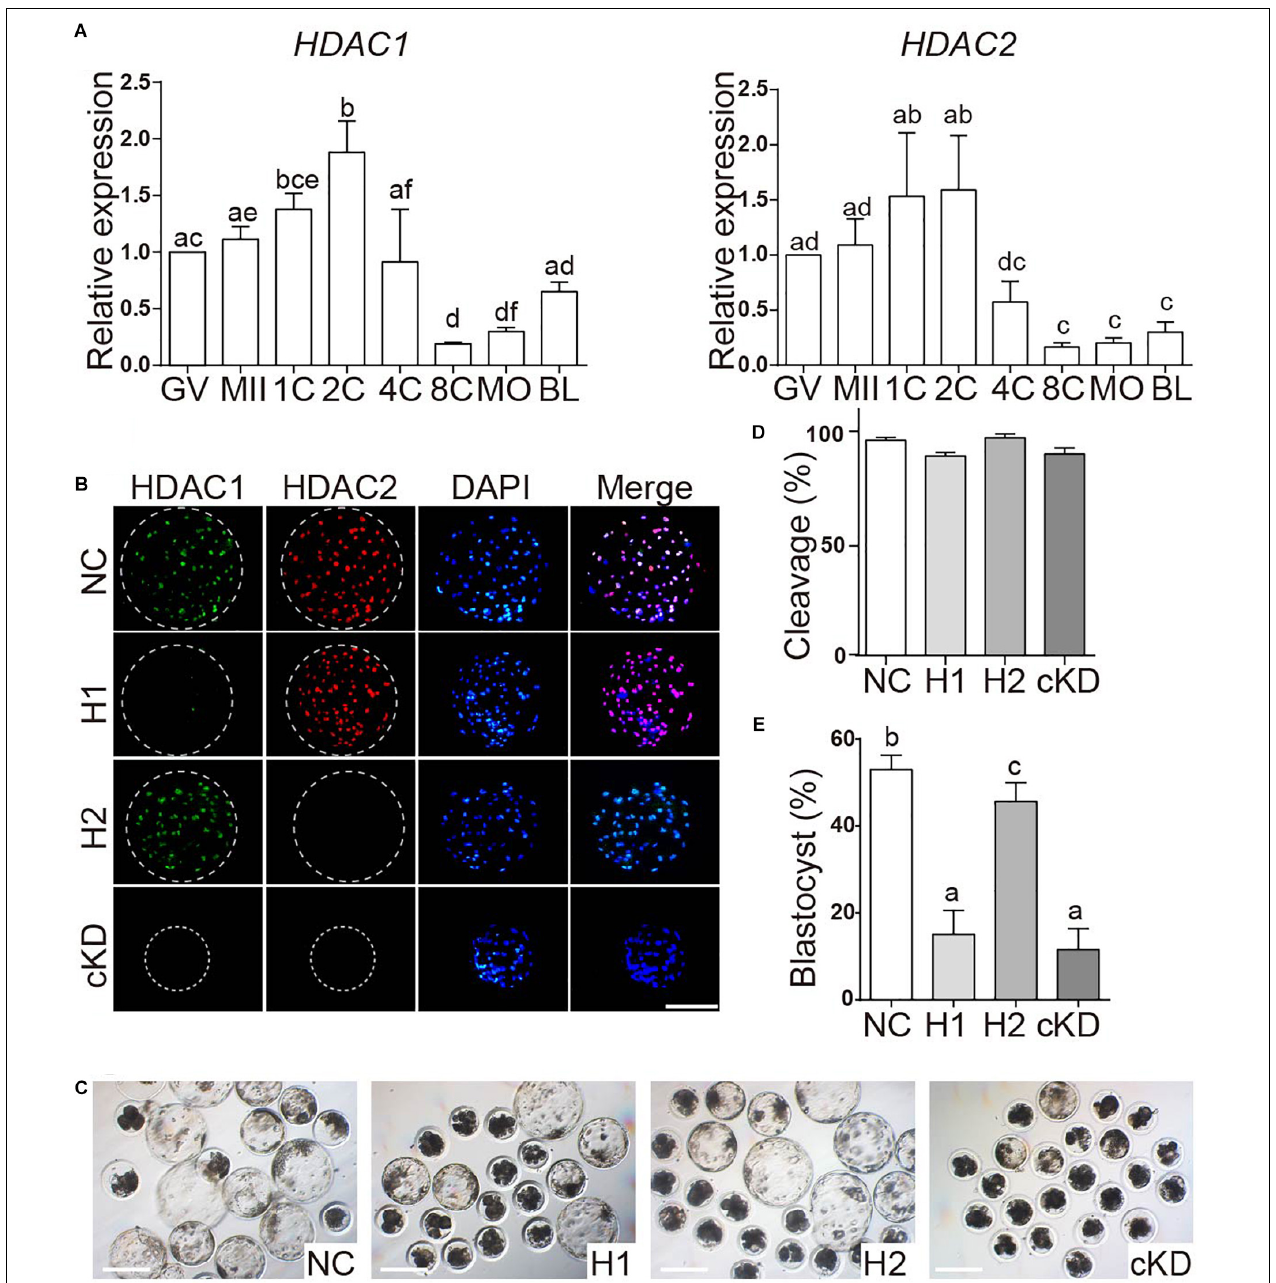
FIGURE 5 | Effect of HDAC1 and HDAC2 KD on the developmental efficiency of porcine embryos. (A) Expression of HDAC1 and HDAC2 mRNA in oocytes and early embryos. Relative abundance of HDAC1 and HDAC2 was determined by qPCR. Data are shown as mean ± SEM and different letters on the bars indicated significant differences ( P < 0.05). (B) Validation of the efficiency of RNAi-mediated HDAC1/HDAC2 KD in porcine early embryos. Immunofluorescence analysis of HDAC1 and HDAC2 protein abundance in blastocysts. HDAC1 (green), HDAC2 (red), nuclei (blue). NC, negative control siRNA; H1, HDAC1 siRNA; H2, HDAC2 siRNA; cKD, HDAC1 and HDAC2 siRNA. (C) Representative images of NC, HDAC1 KD, HDAC2 KD, and cKD porcine embryos after in vitro culture for 7 days. (D) . (E) Developmental rates of porcine early embryos. Three independent replicates; all data were represented as mean ± SEM and different letters on the bars indicate significant differences ( P <